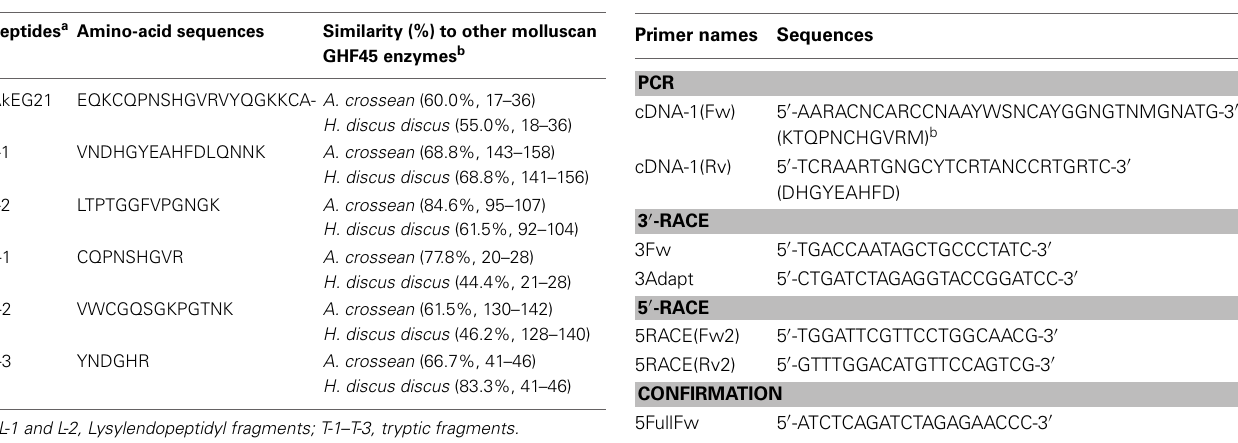
reaction mixture was subjected to TLC. (B) The reaction mixture of 0.05mL containing 0.05mg of G3–G6, 10mM sodium phosphate (pH6.0), and 7 U of AkEG21 was incubated at 30 ◦ C for 24h, then subjected to TLC. G1, glucose; G2, cellobiose; G3, cellotriose; G4, cellotetraose; G5, cellopentaose; G6, cellohexaose. Mk, marker sugars.